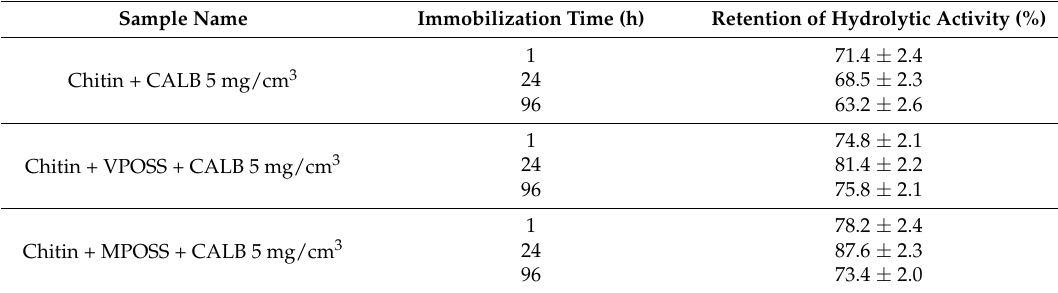
Table 2. Retention of the hydrolytic activity of products after immobilization.